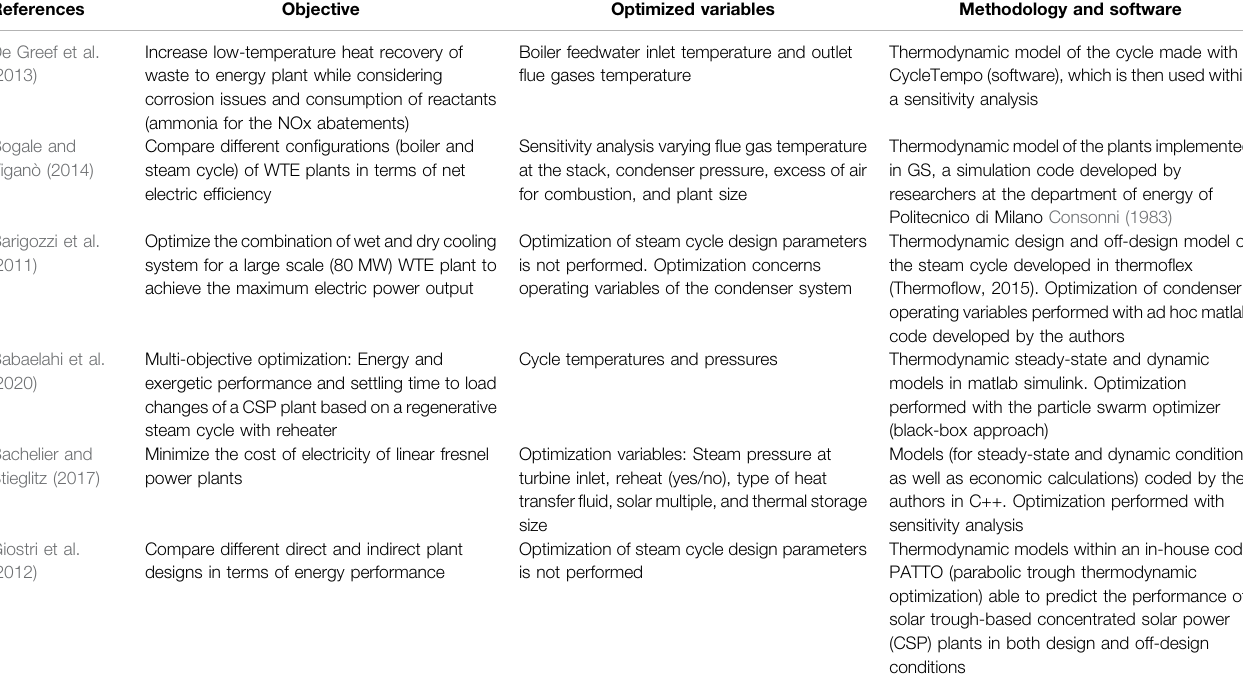
TABLE 3 | List of recent contributions on the design optimization of CSP and WTE